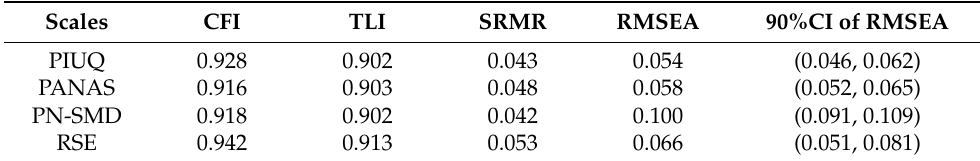
Table 1. Confirmatory factor